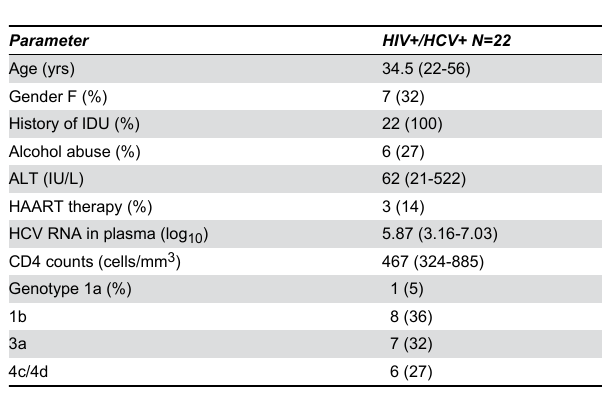
Table 2. Characteristics of 22 HIV/HCV coinfected patients undergoing treatment with Pegylated interferon and Ribavirin.